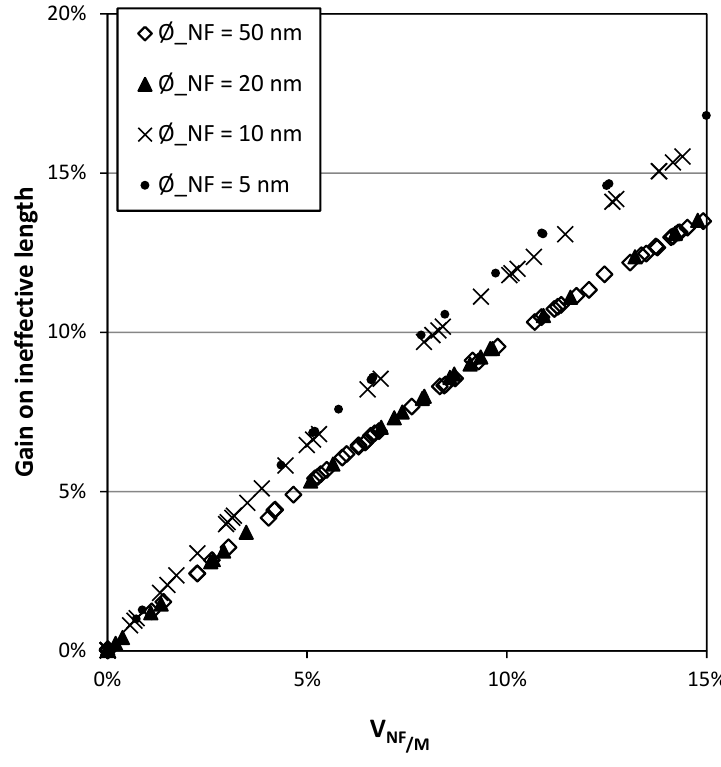
Figure 7. Gain on ineffective length as a function of NF volume fraction, for different NF diameters, with homogenized reinforced